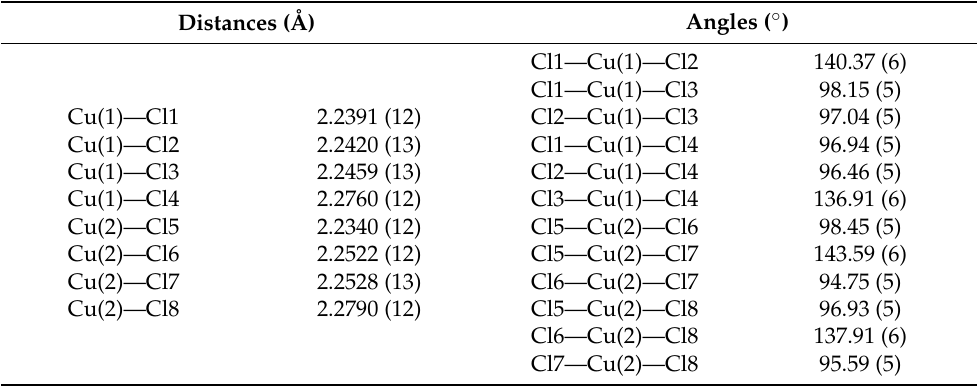
Table 2. [Cu(1)Cl 4 ] 2 − and [Cu(2)Cl 4 ] 2 − bond lengths and angles.